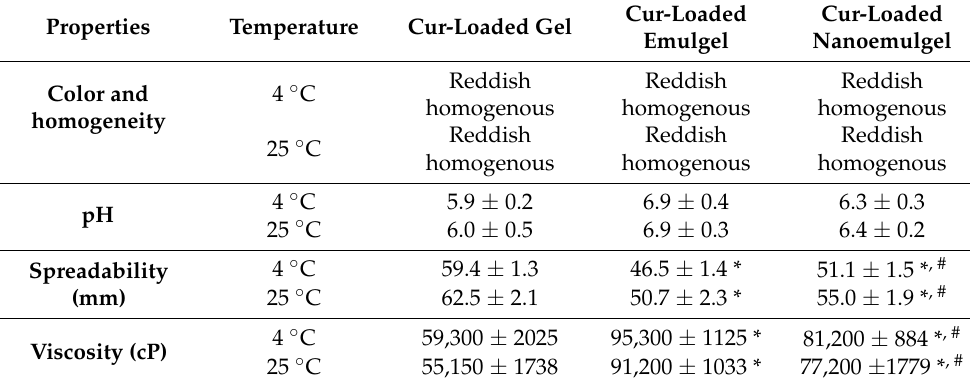
Table 5. Physical characterization of Cur-loaded formulations following 6 months storage at a relative humidity of 60% and temperature of 4 ◦ C.